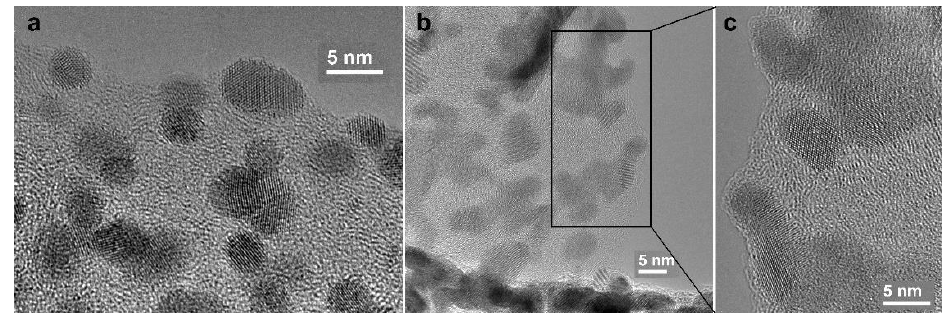
Figure 4. HRTEM images of Pt nanoparticles for platinated pyrolyzed composite 1: ( a ) spherical morphology; ( b ) intermediate (random) shape; ( c ) enlarged image of selected area in ( b ).